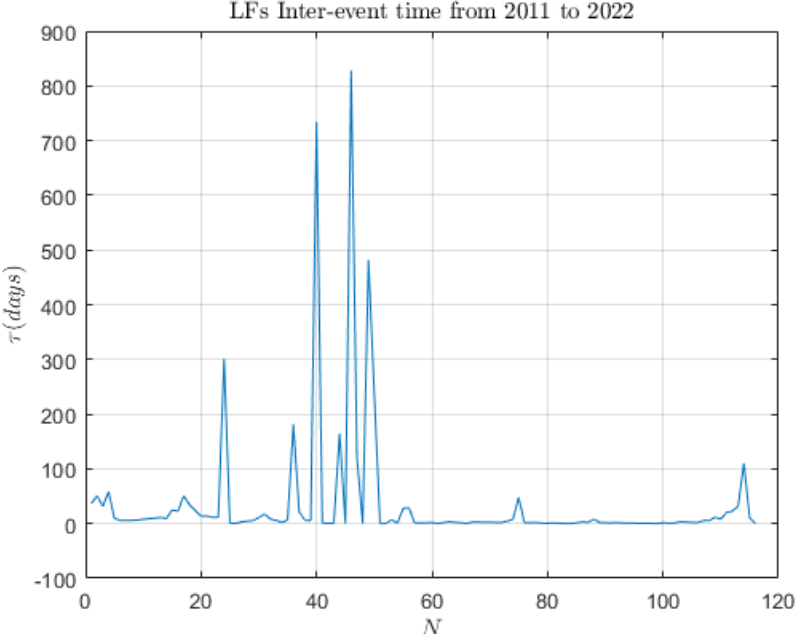
Figure 4. Inter-event time interval (days) between lava fountain (LF) episodes occurring at Etna from January 2011 to July 2022 plotted against the event number (reported in the first column of Table S1). Table 2. Parameters of the power-law model for the inter-event time dataset.